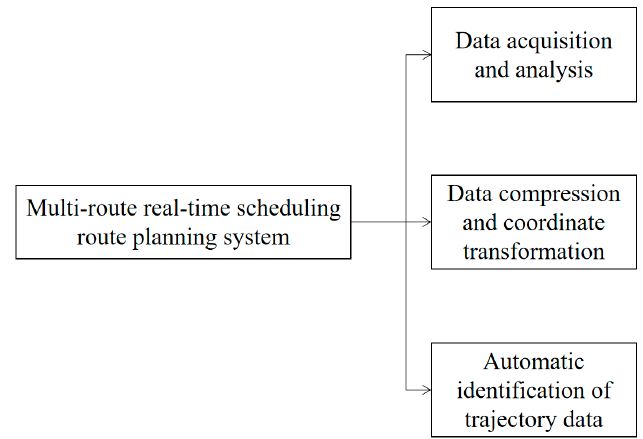
Figure 5. Multi-route real-time scheduling planning model.